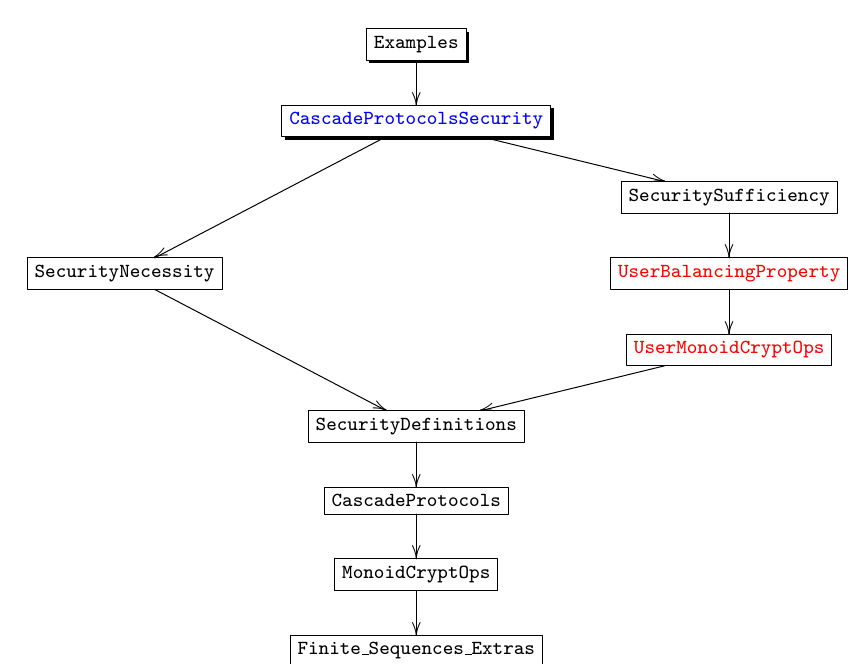
Fig. 1. Hierarchy of theories and subtheories — formalization of security of cascade